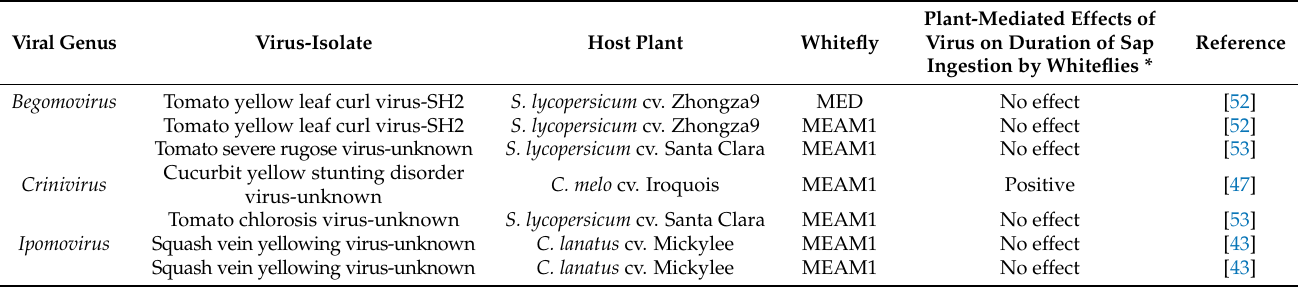
Table 3. Plant-mediated effects of virus infection on whitefly feeding